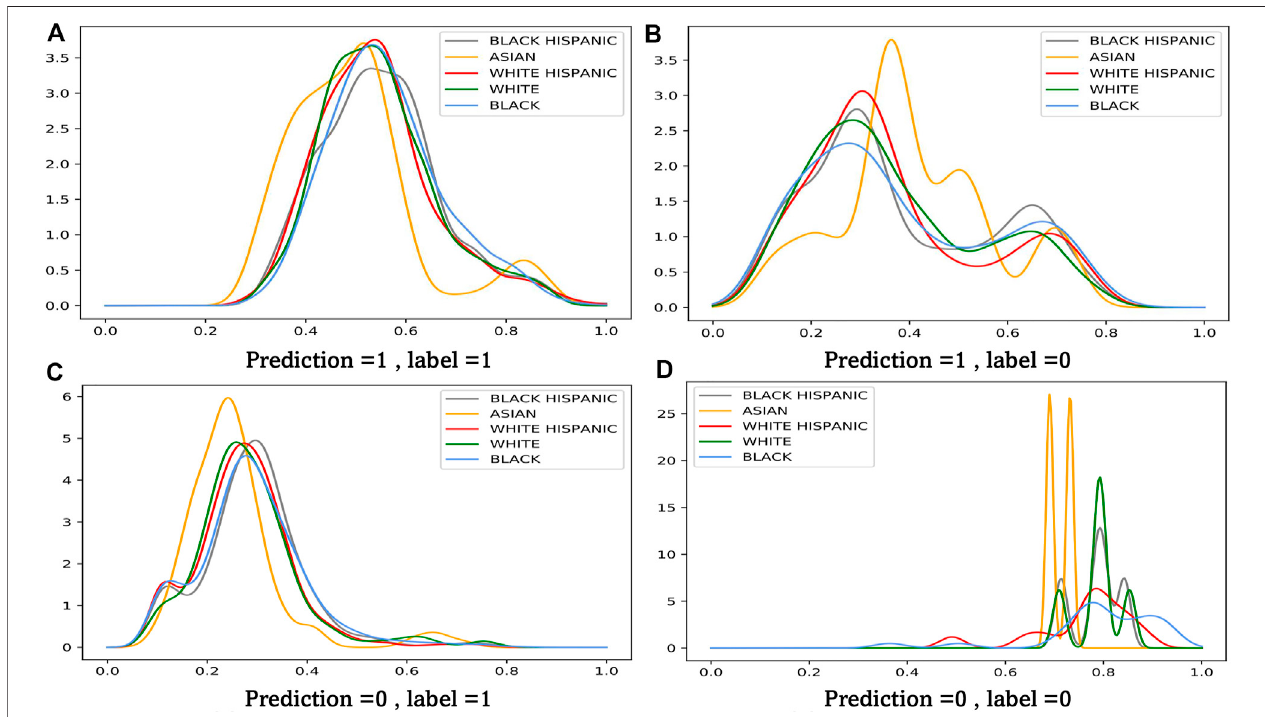
FIGURE 3 | Weight Analysis of our method. (A) Prediction (cid:1) 1 , label (cid:1) 1 (B) Prediction (cid:1) 1 , label (cid:1) 0 (C) Prediction (cid:1) 0 , label (cid:1) 1 (D) Prediction (cid:1) 0 , label (cid:1) 0